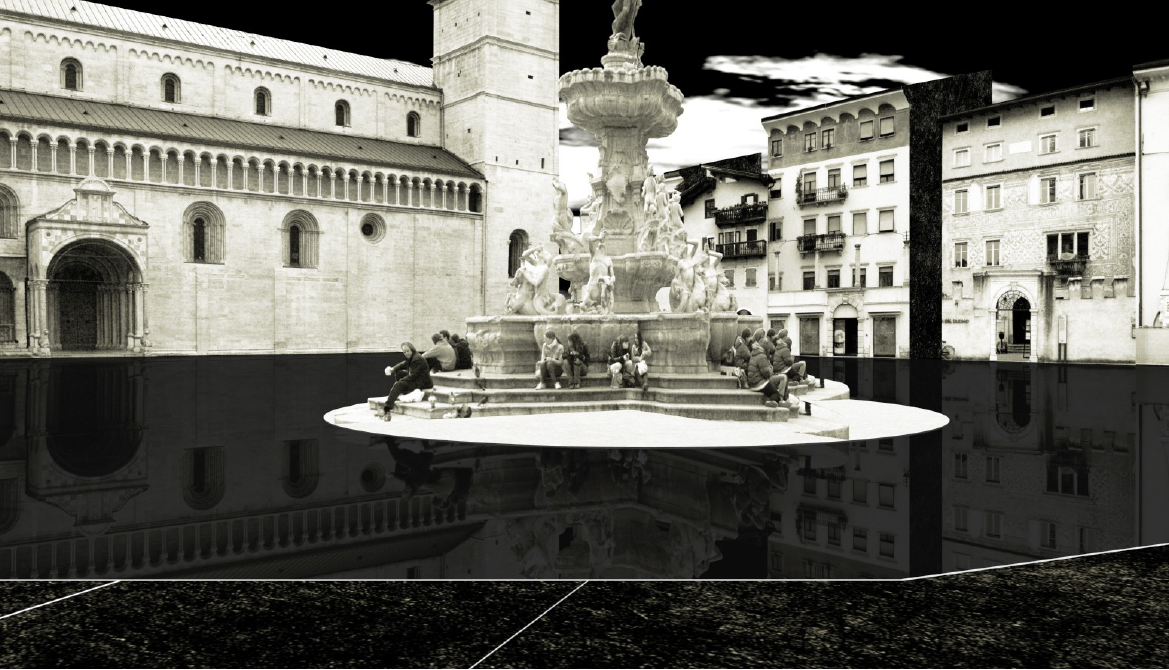
fig. 2 Trento model: the cathedral in the old town